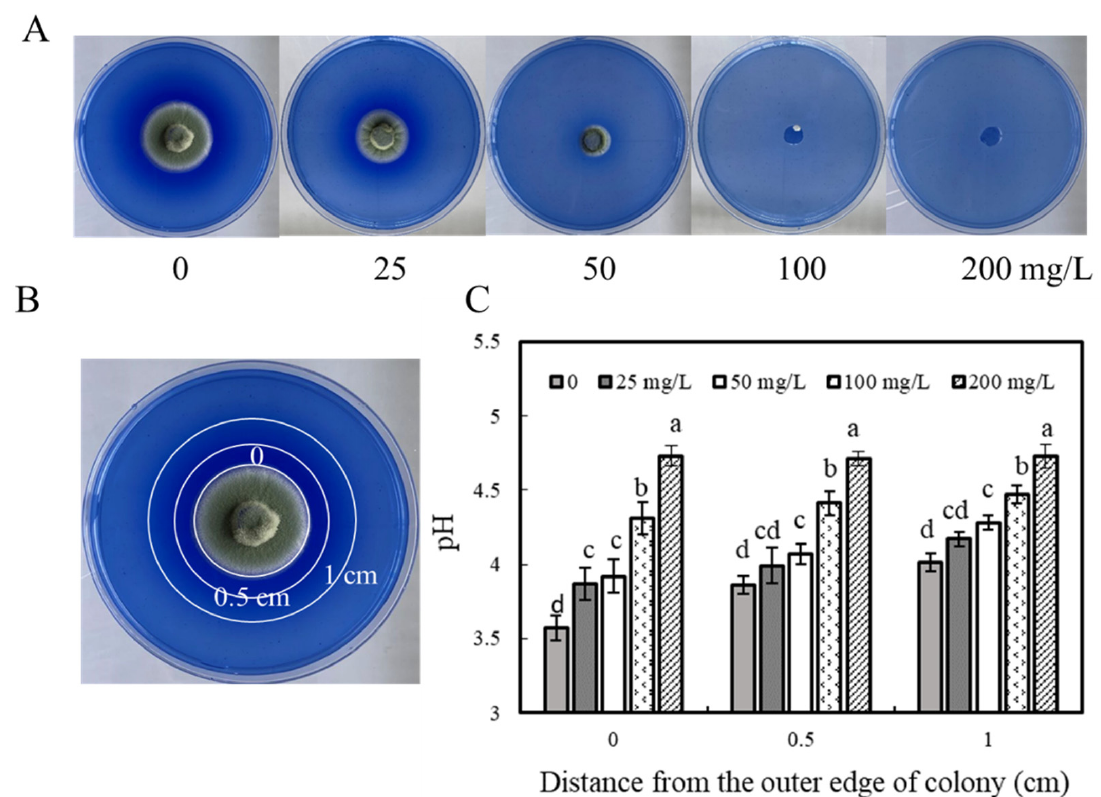
Figure 4. Effect of ε -PL treatment on aniline blue dye test to determine acidity. ( A ) The colony status of P. expansum on PDA after adding aniline blue for 6 days; ( C ) After 6 days of culture, the pH of the PDA medium at 0, 1, or 2 cm from the outer edge of the lesion ( B ). The vertical bar represents the standard deviation. According to Tukey’s test, different letters indicate significant differences ( p < 0.05).